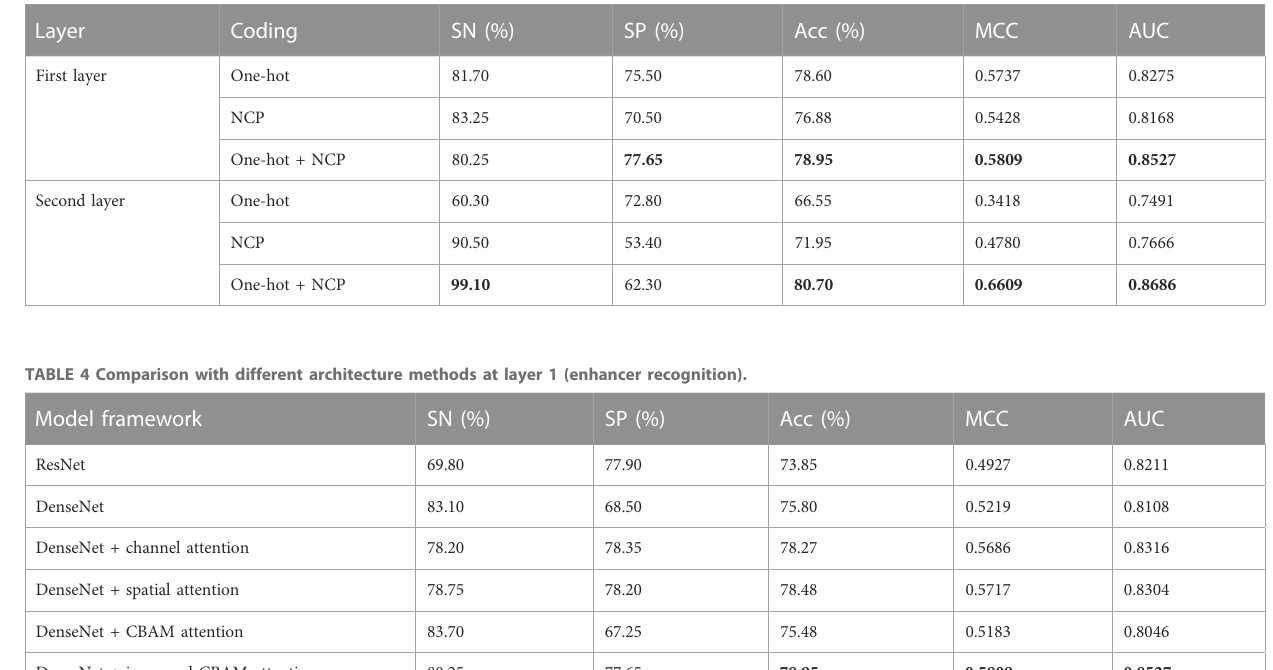
TABLE 3 Comparison results of different coding schemes.